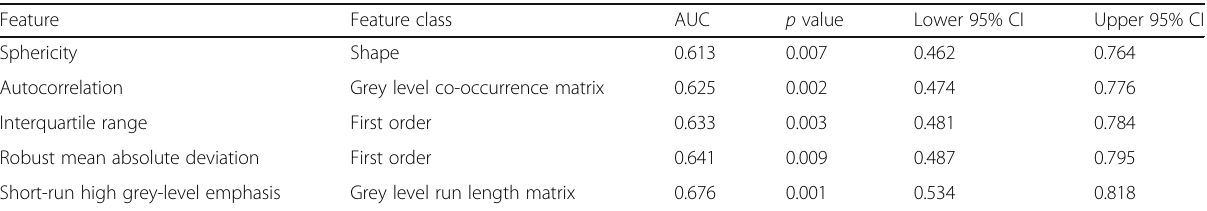
Table 2 Values of feature parameters differetiating between low and high Ki-67 expression on digital breast tomosynthesis